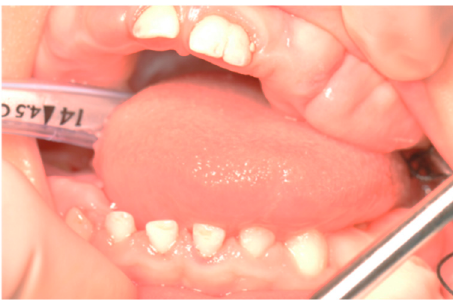
Figure 3. Intra-operative photo: orotracheal intubation in general anesthesia; gingival fibromatosis.